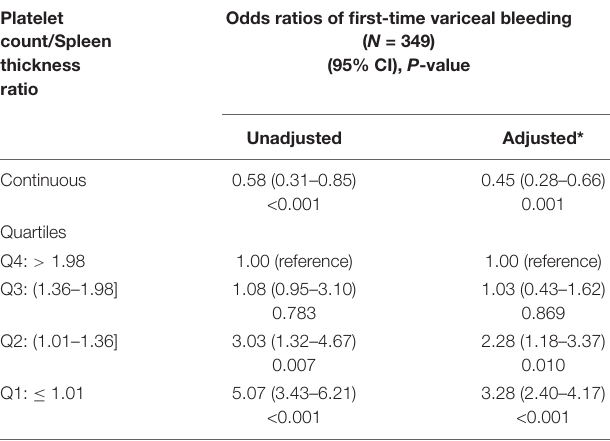
TABLE 2 | Adjusted effects of the platelet count/spleen thickness ratio on first-time variceal bleeding within one year in cirrhotic patients with moderate or severe esophagogastric